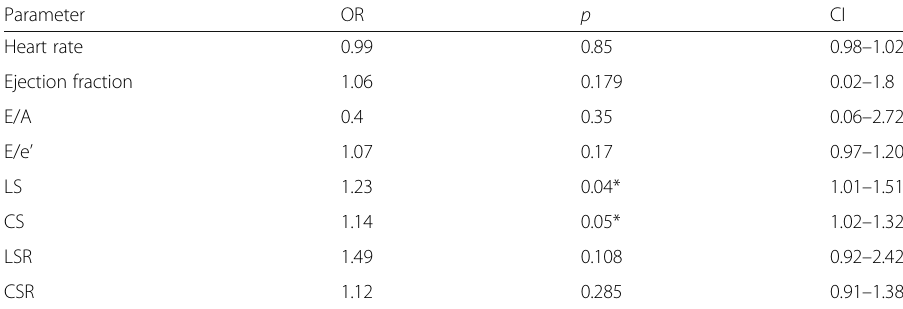
Table 3 Association between 24 h echocardiographic metrics and mortality for C57BL/6J mice Parameter OR p CI Heart rate 0.99 0.85 0.98 – 1.02 Ejection fraction 1.06 0.179 0.02 – 1.8 E/A 0.4 0.35 0.06 – 2.72 E/e ’ 1.07 0.17 0.97 – 1.20 LS 1.23 0.04* 1.01 – 1.51 CS 1.14 0.05* 1.02 – 1.32 LSR 1.49 0.108 0.92 – 2.42 CSR 1.12 0.285 0.91 – 1.38 CI indicates confidence interval, CS , global circumferential strain, CSR peak systolic circumferential strain rate, E/A ratio of peak flow velocity across the mitral annulus during early and late diastole, E/e ’ ratio between mitral inflow and mitral annular excursion velocity during early diastole, LS global longitudinal strain, LSR peak systolic longitudinal strain rate, OR odds ratio. *Significant association with mortality based on univariate logistic regression